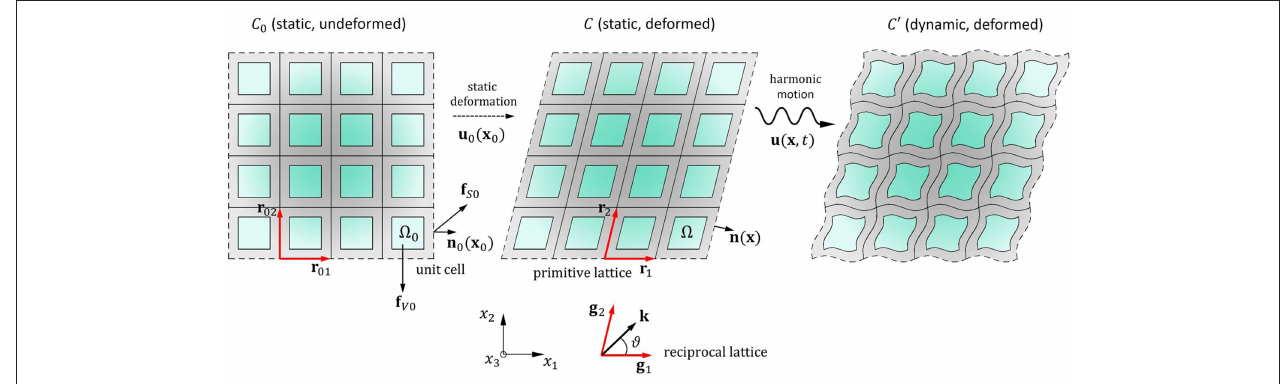
FIGURE 1 | Schematic representation of the Updated Lagrangian (UL) scheme for the infinite phononic crystal (PC) plate.